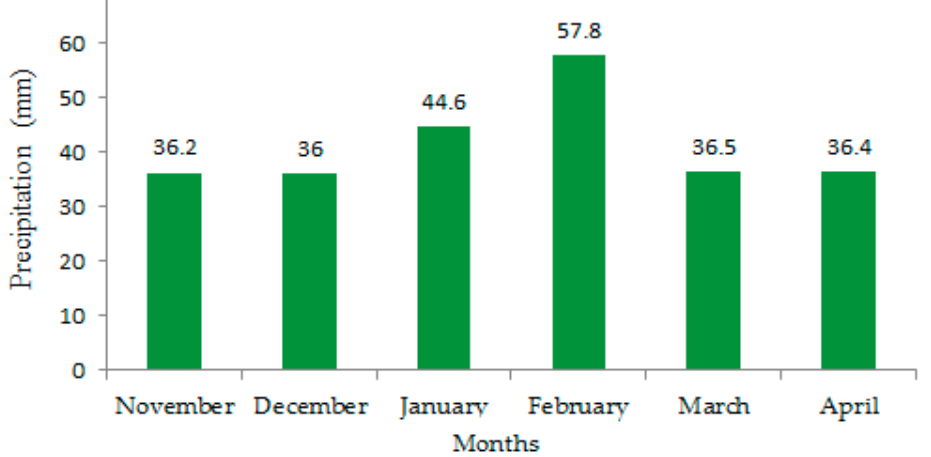
Figure 4. Monthly distribution of the maximum 24 h accumulated precipitation (mm) at the given station among all the studied events.